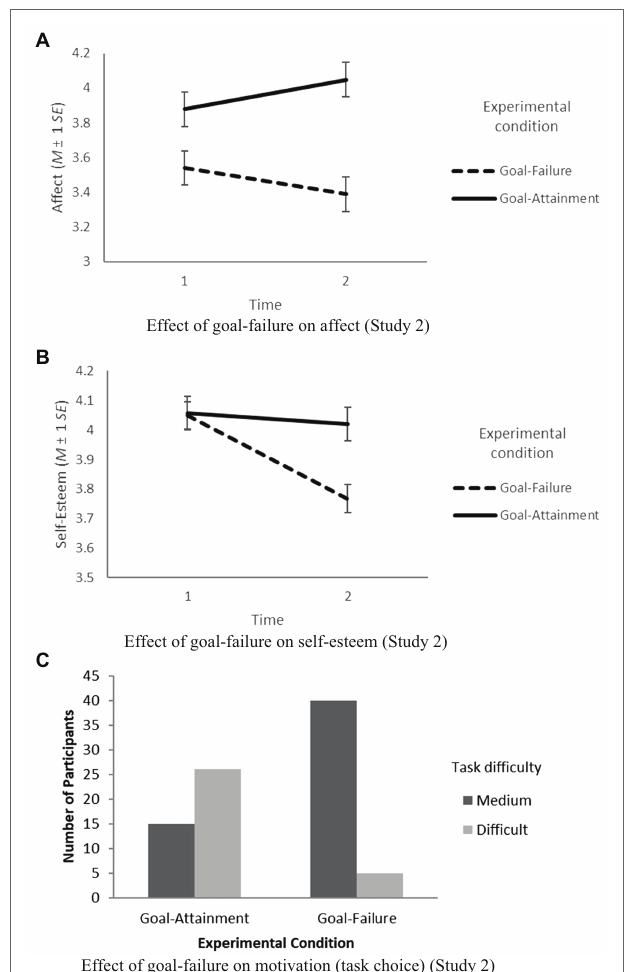
FIGURE 3 | Effects of goal-failure on affect (A) , self-esteem (B) , and motivation task choice (C) in Study